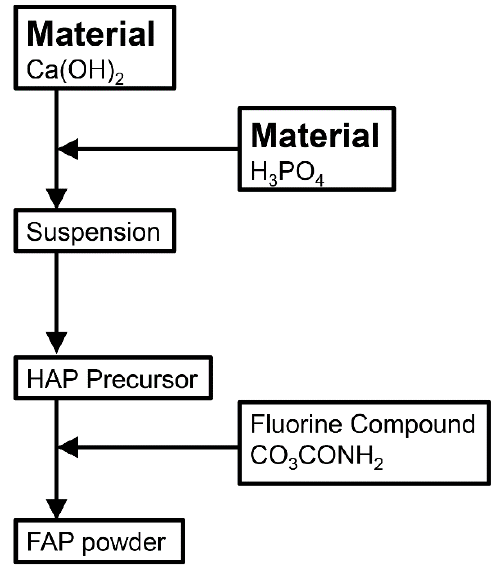
Figure 1. Schematic diagram of the synthesis of the FAP powder.